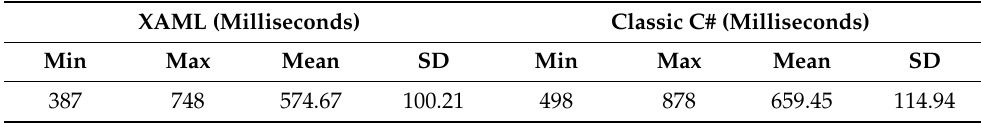
Table 2. The descriptive statistic of the fixation duration mean is based on XAML and classic C# ( n = 36).